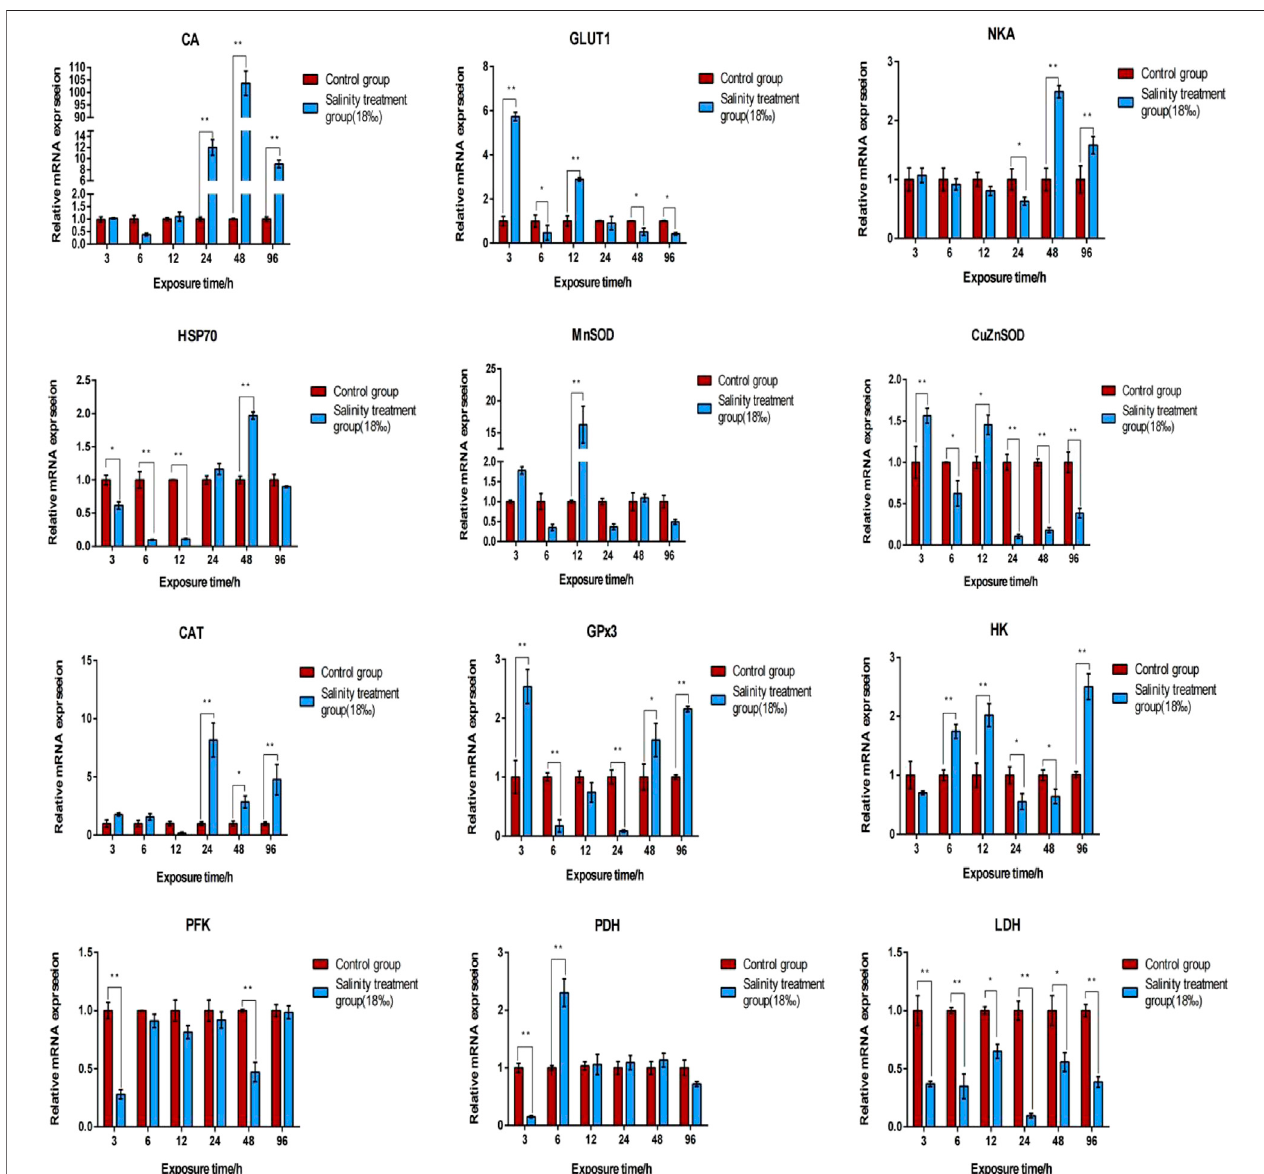
FIGURE5| Validationoftheexpressionpro fi lesof12DEGsidenti fi edinthehepatopancreastissueof M.nipponense usingqPCR.Log-foldchangesareexpressed as the ratio of gene expression after normalization to β -actin expression levels. Data are shown as mean ± SE (standard error) of tissues in three separate individuals. *indicates signi fi cant difference ( p < 0.05), pp indicates extremely signi fi cant difference ( p < 0.01).